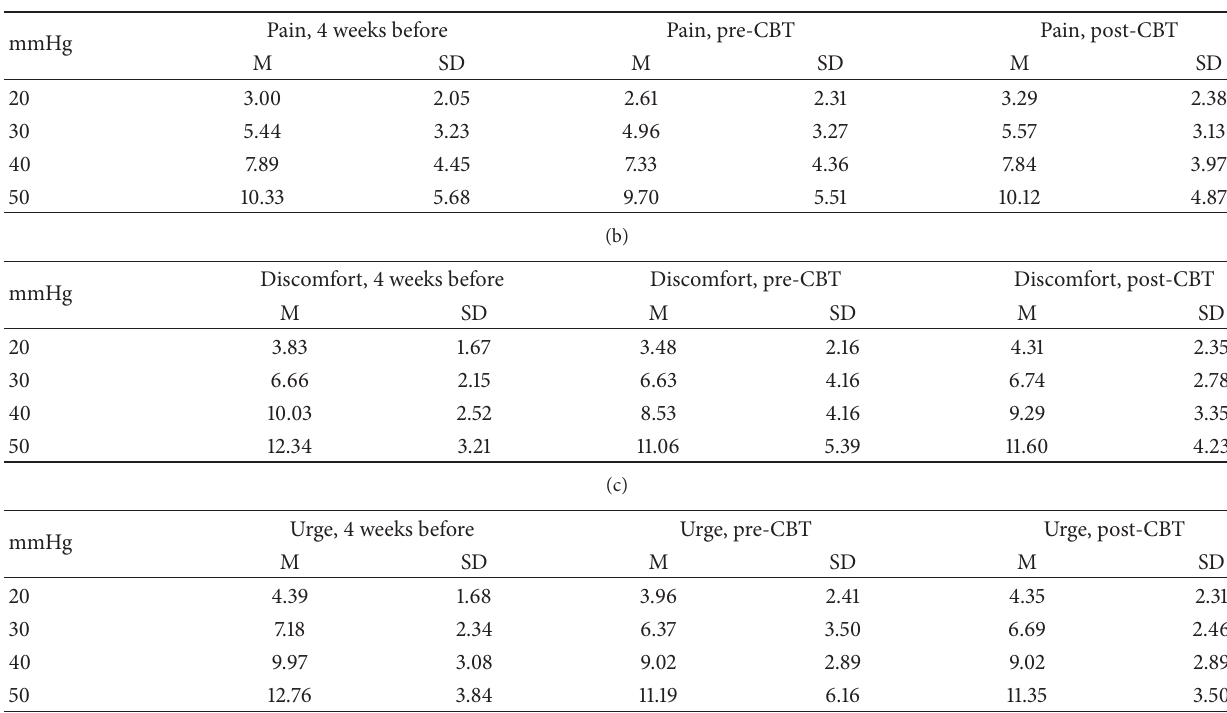
Table 1: Descriptive data for dependent